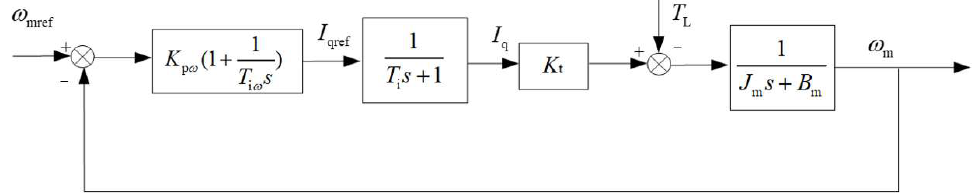
Figure 10. Simplified control chart for the speed loop.